Question: Write a caption explaining this figure to a reader.
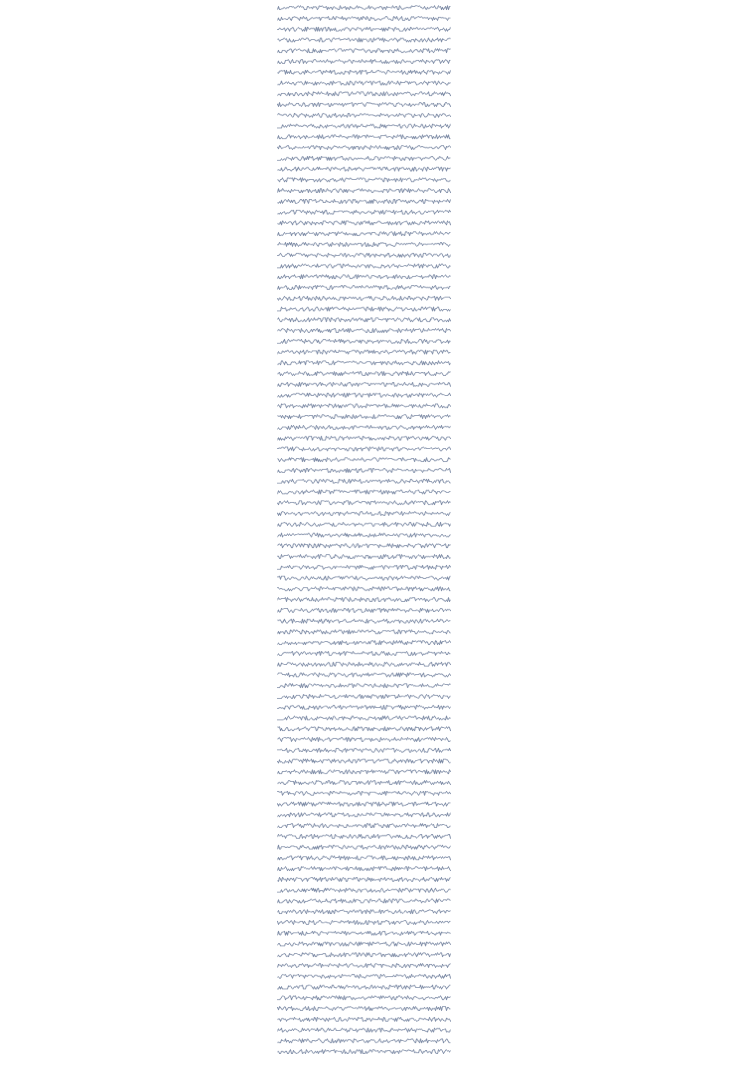
Answer: 100 trendlines for all NIST tests p-values on vectors of length 3750 varying non-end elements from 1 to 100.